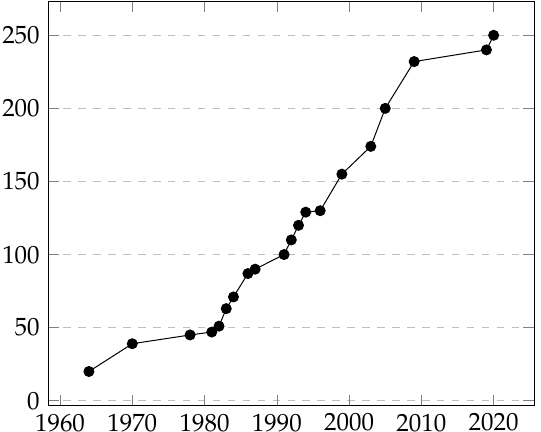
Figure 1. Size of general number factored versus year.